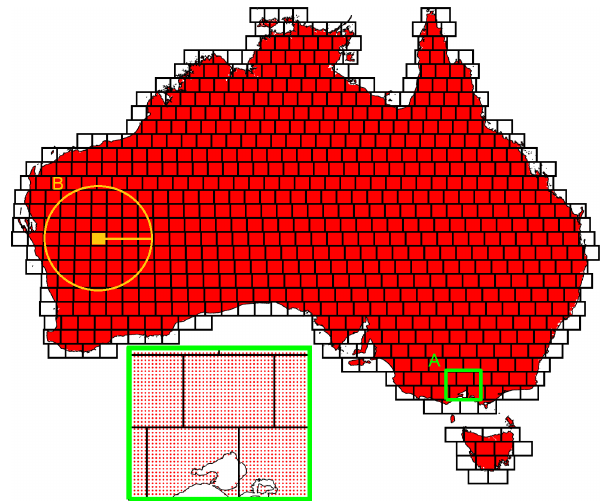
Figure 2. The GRACE GSFC Mascon grid (black rectangles) and the CABLE 0.05 ◦ grids (red dots) in Australia. The green inset shows details of rectangle A. The orange circle B shows the number of mascon cells inside a ∼ 3 ◦ radius, which are used to update the state variables inside the center mascon (filled orange). Processing details can be found in Sect.